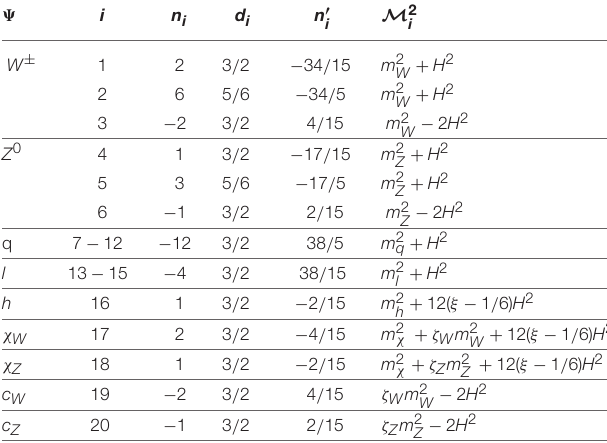
TABLE 1 | The 1-loop effective potential (3.32) contributions with tree-level couplings to the Higgs.